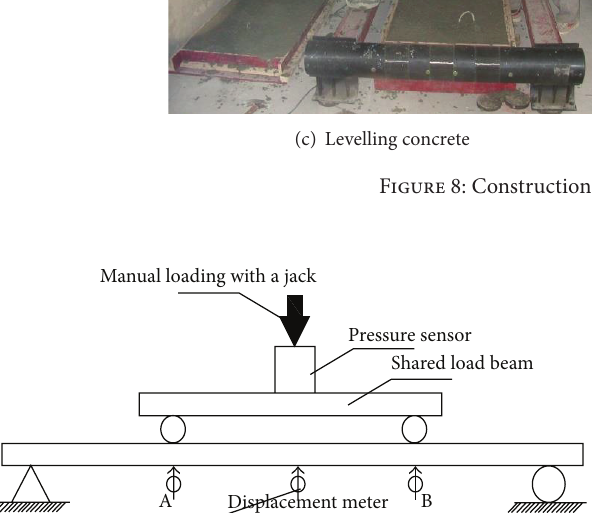
Figure 9: Schematic of the three-dividing-point loading process.